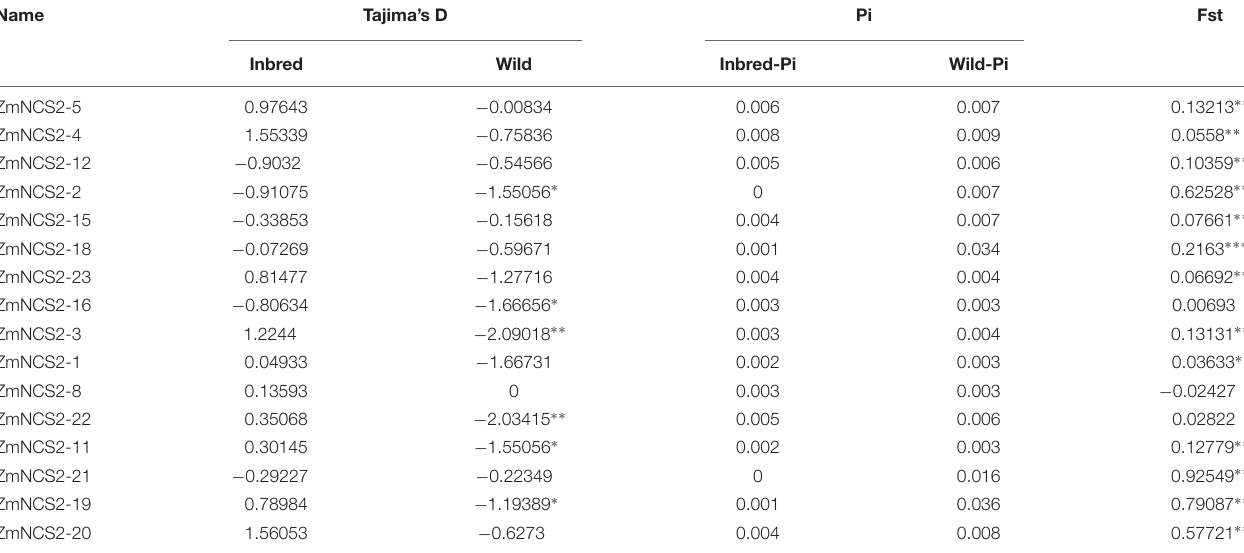
TABLE 5 | Summary of Tajima’s D , Fst, and Pi values in 78 inbred and 22 wild maize lines.